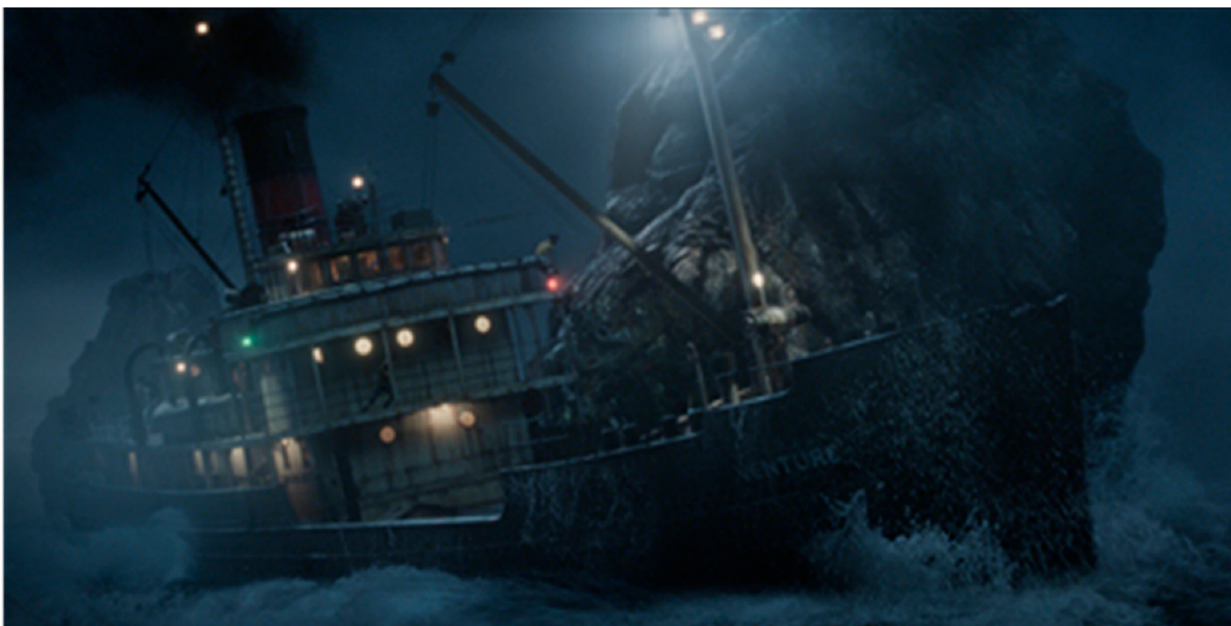
Figure 13. Upon reaching Skull Island, the Venture collides with skull-shaped cliffs (2005). https://www.deviantart.com/3dnutta/art/King-Kong-Venture-71872158 (accessed on 1 January 2021).